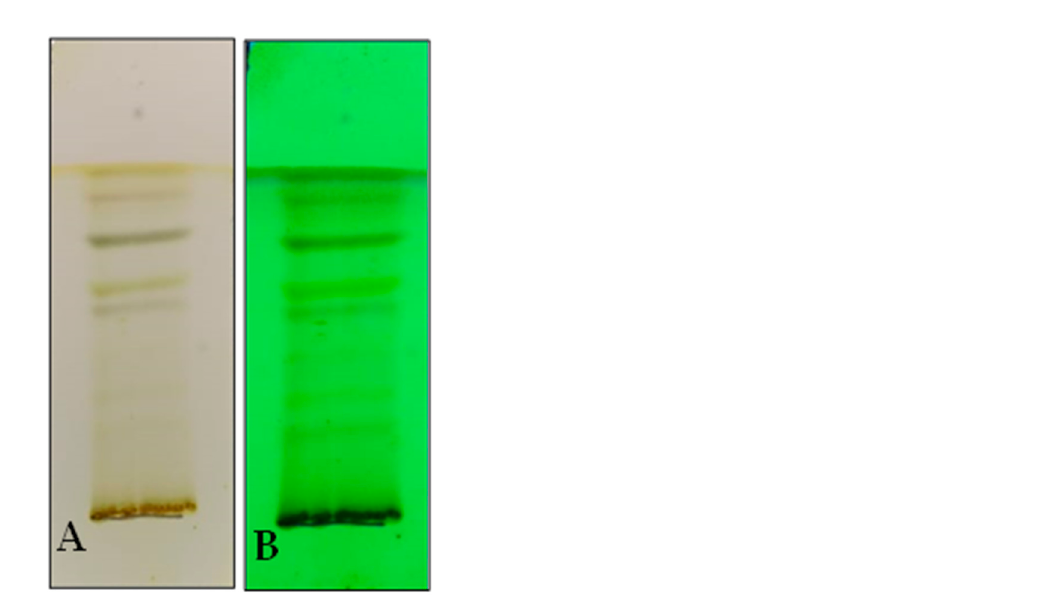
Table 3. Results of TLC fingerprinting of chloroform extract of E. microphylla leaves. S. No. Steroids and triterpenoids Liebermann–Burchard test + (+) present; ( − ) absent.